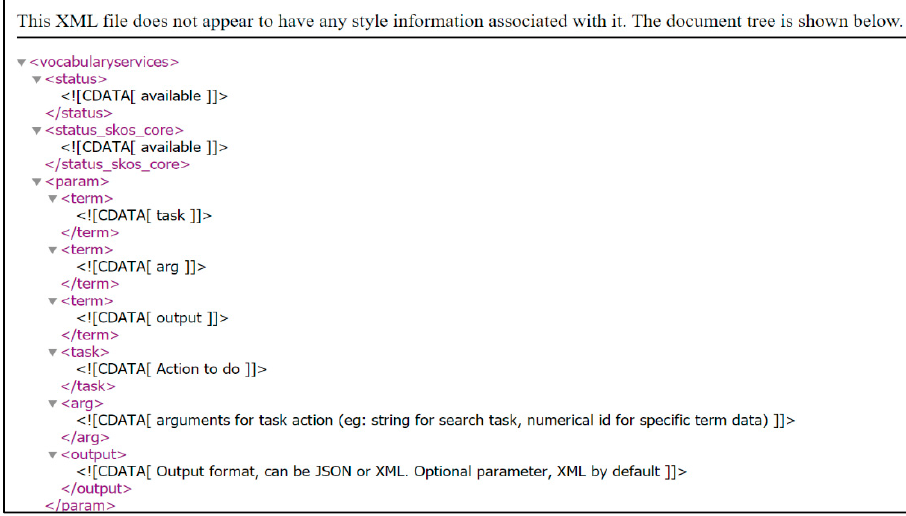
Figure 8. Screen shot of the API web service for the digital thesaurus of ethnic groups in the MRB.